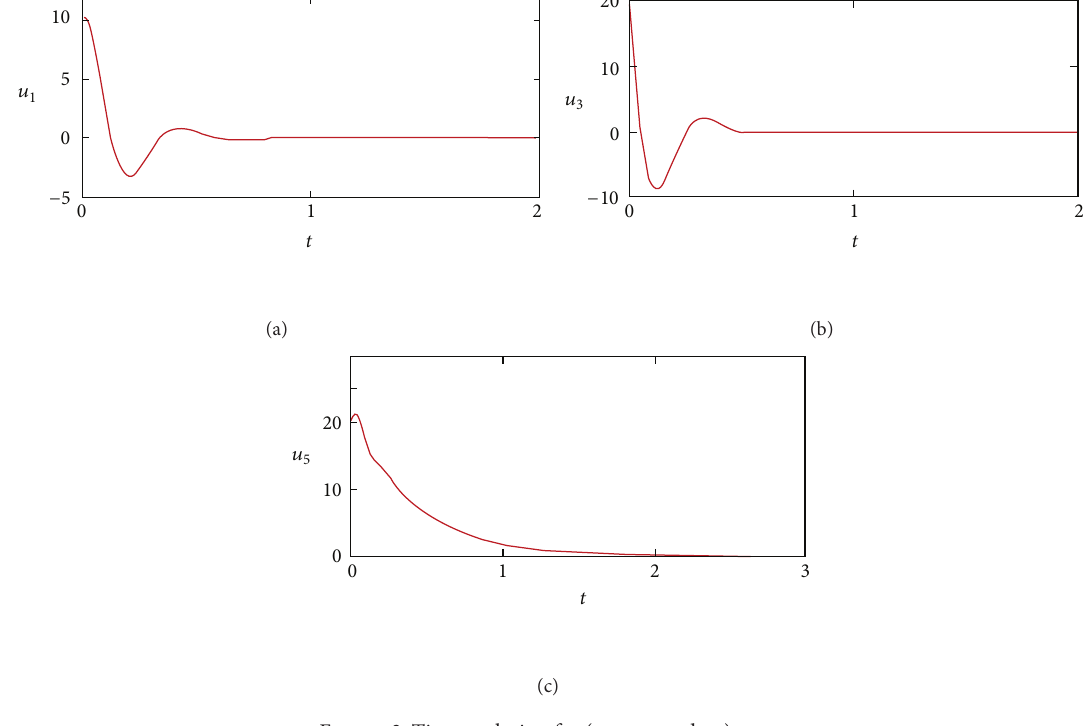
Figure 2: Time evolution for ( 𝑢 1 , 𝑢 3 , and 𝑢 5 ) at 𝑝 0 .